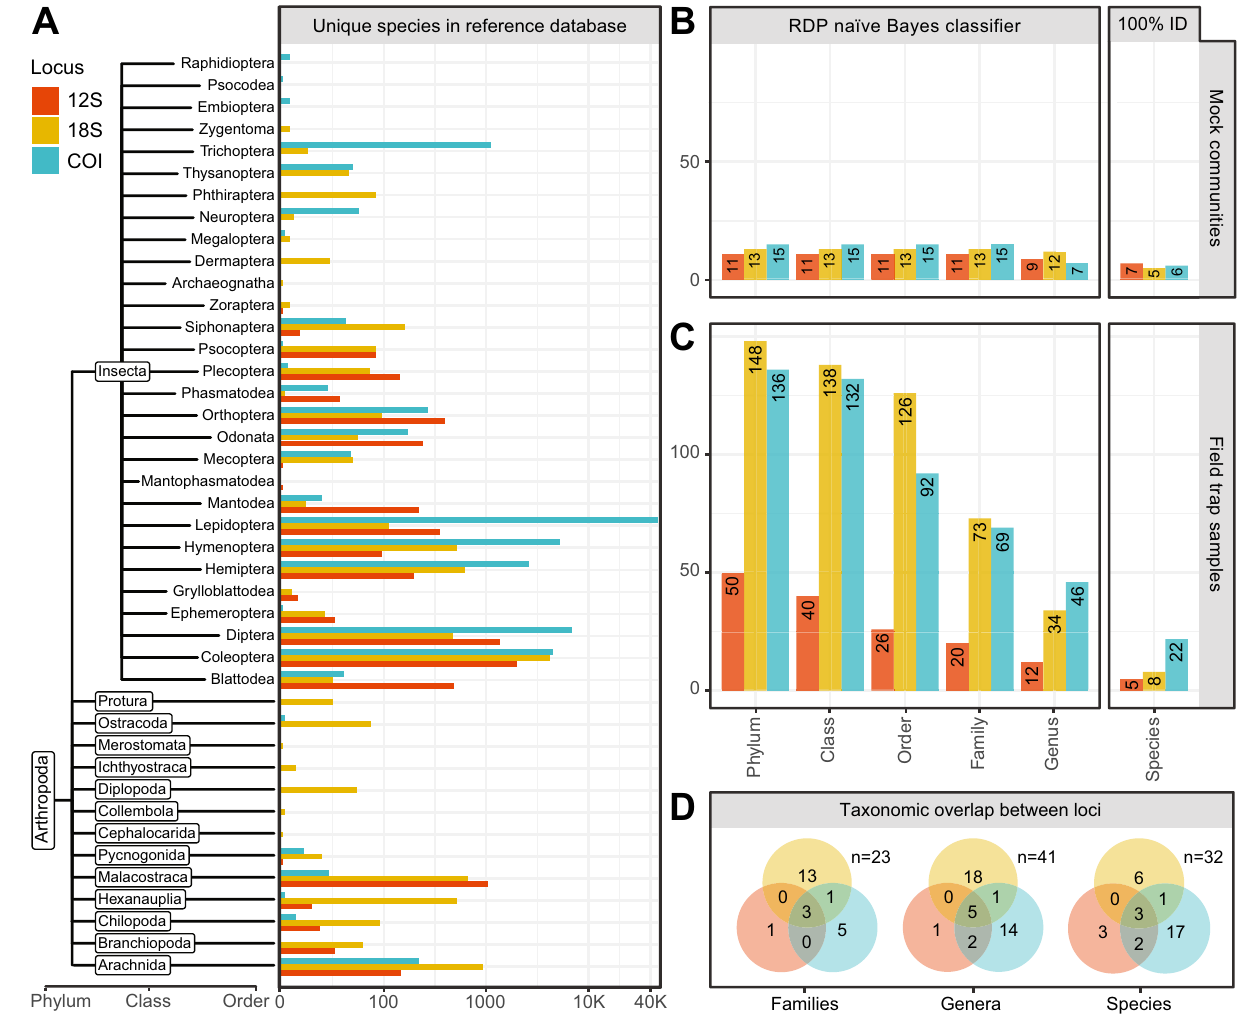
Figure 2. ( A ) Taxonomic composition of the reference database, displaying number of unique species for each order within Insecta, as well as for other classes of Arthropods. Number of amplicon sequence variants (ASVs) from ( B ) mock communities and ( C ) field trap samples successfully assigned to taxonomic ranks for each locus using the Ribosomal Database Project (RDP) naïve Bayesian classifier and exact matching with reference sequences. ( D ) Taxonomic overlap between loci at the family, genus, and species level for all